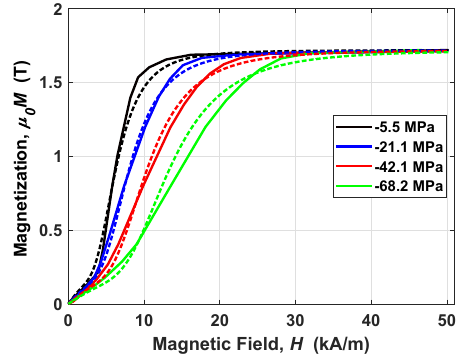
Figure 3. Magnetic characteristic (first quarter) of SA Galfenol, at different compressive stress—comparison between measurements (solid line) and simulation of Equation (11) (dashed line).